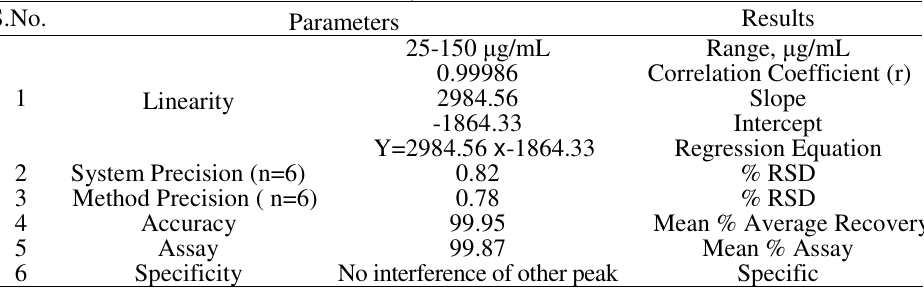
Table 4. Summary of Validation